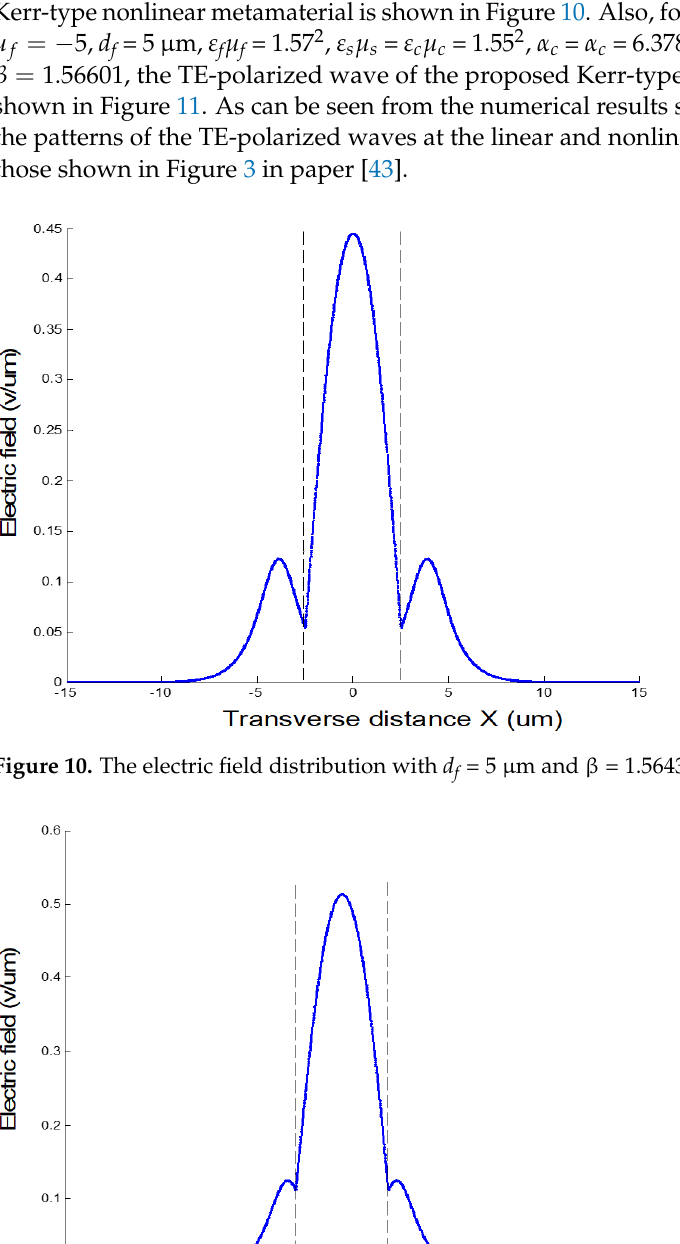
Figure 9. The electric field distribution with respect to the six points, A, B, C, D, E, and F, as shown in Figure 8.